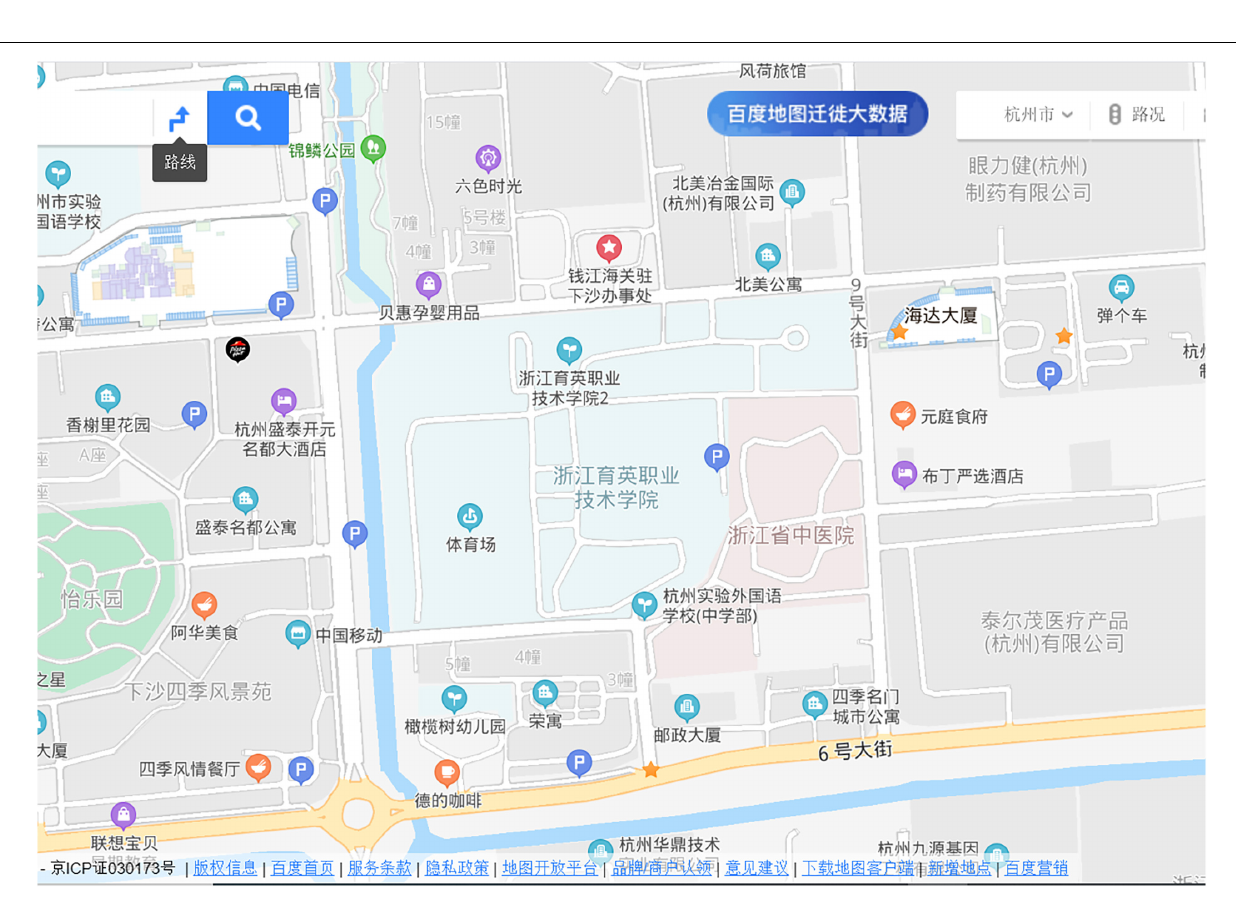
FIGURE 4 | The assisted 2D